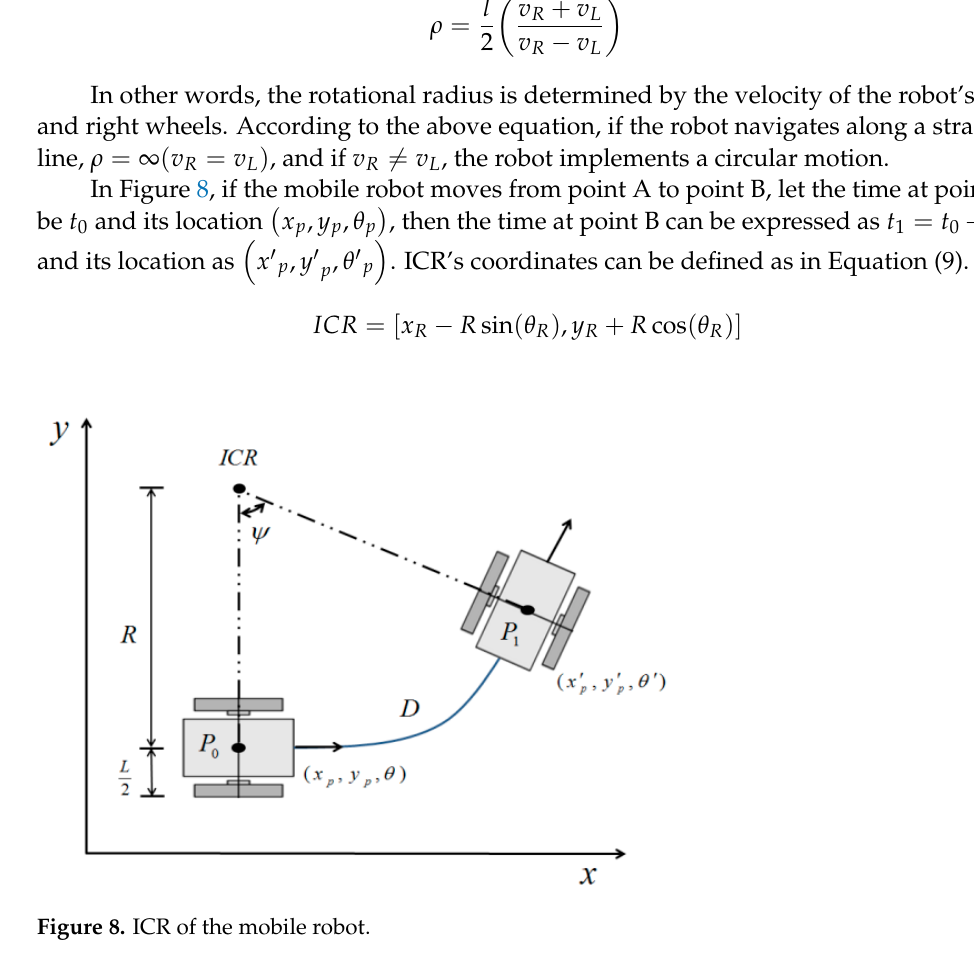
′ at the instant of time lapse of t δ from